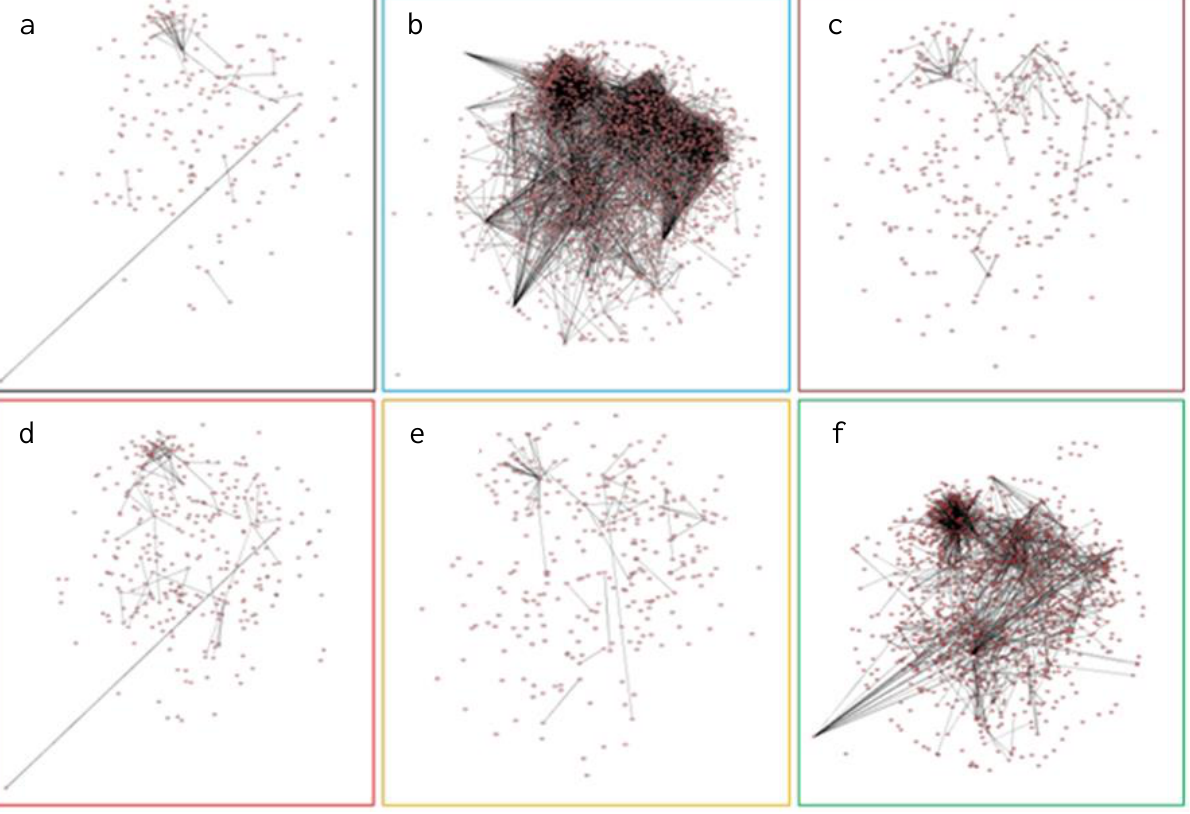
Figure 5. Protein-protein interaction (PPi) networks of affected genes ( i.e ., M -value ≥ 1 or ≤ −1) for all the six stresses. ( a ) AgNPs; ( b ) Cold; ( c ) Drought; ( d ) Ag + ; ( e ) Heat; ( f ) Salt. Nodes represented proteins and edges showed the interaction between